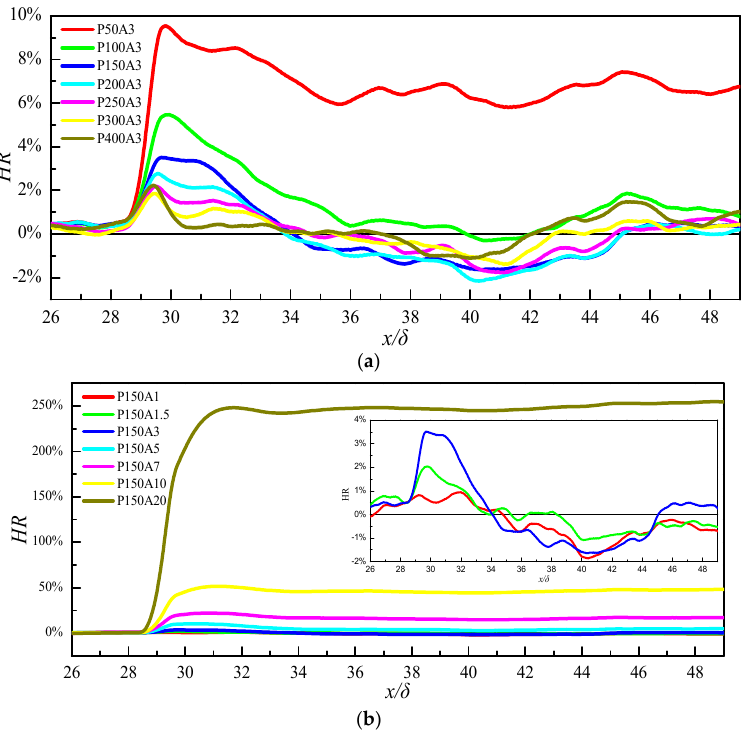
Figure 6. The rates of the change of wall heat flux ( HR ) for Group 1 ( a ) and Group 2 ( b ). Table 2. Peak values of DR and HR .